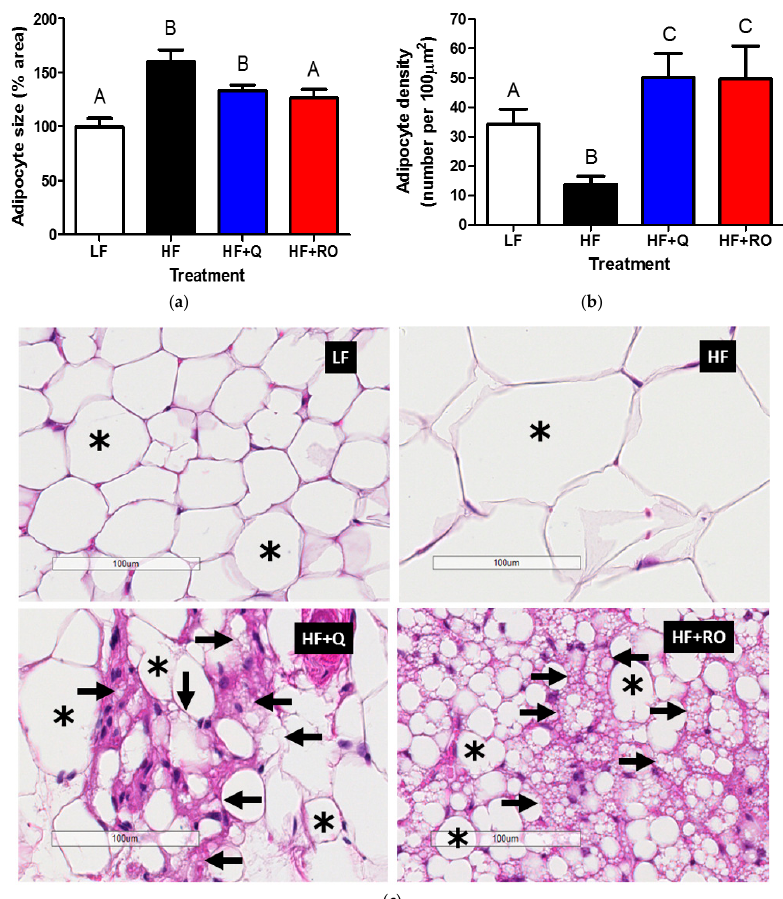
Figure 2. Adipocyte size ( a ) as the percent area, or the number of adipocytes in a given area of tissue, and density ( b ) were determined in inguinal white adipose tissue (IWAT) from mice were fed low fat (LF; white), high fat (HF; black), high fat + quercetin (HF + Q; blue) or high fat + ROE (HF + RO; red) diets and representative images are shown ( c ). Graphs are mean ± SEM. Different letters denote significant differences between groups at p < 0.05. Asterisks represent unilocular adipocytes and arrows point to multilocular